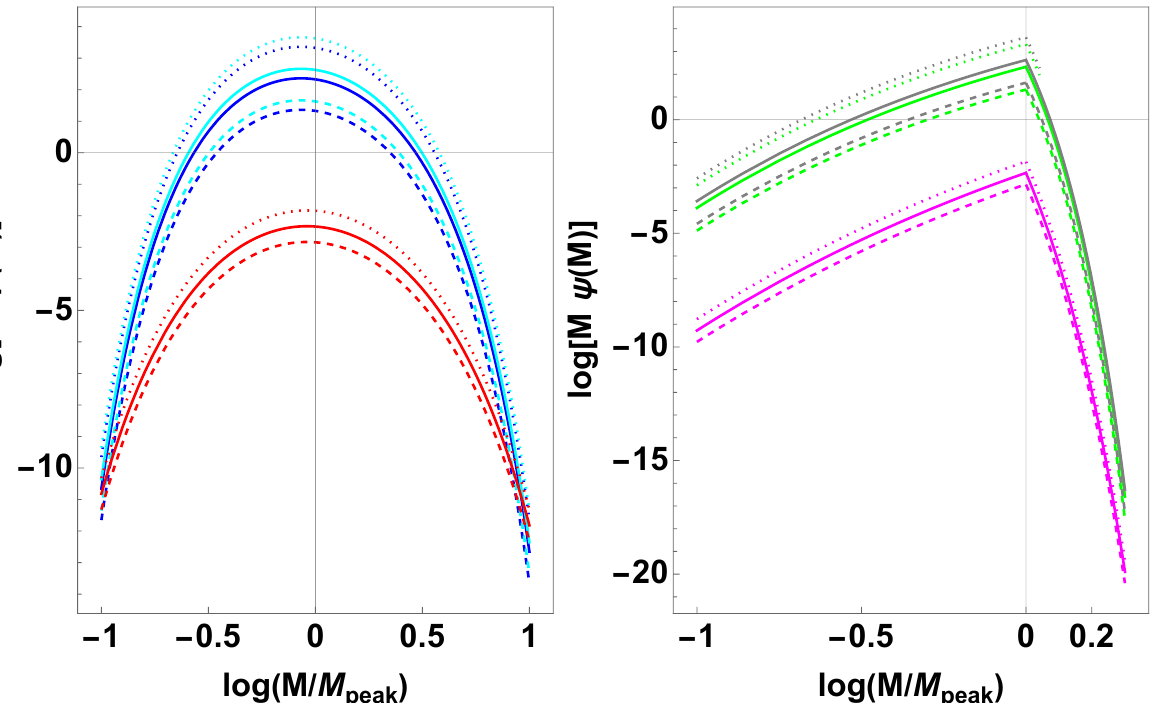
Figure 5. The weighted mass function M ψ ( M ) plotted for the Gaussian and Broken power law power spectra in the left and right panels, respectively. P 0 = 0.02 has been used for all the cases presented. In the left (right) panel, blue (green) curves are for w = 1 with T RD = 10 MeV, cyan (grey) curves are for w = 1 with T RD = 5 MeV and red (magenta) curves are for w = 1/3. The solid, dashed and dotted lines signify the cases with M peak = 1, 10 and 0.1 M , respectively. (cid:12) In [168], M ψ ( M ) for the KD and RD epochs is compared for two different values of k M and M 10 18 gm. PBHs of mass around peak leading to abundant PBH around (cid:39) (cid:12)